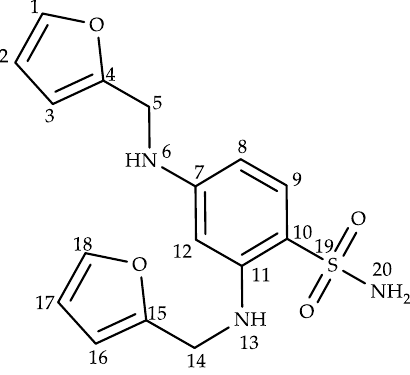
Figure 3. Structure of impurity G. Table 1. 1 H, 13 C-NMR, and 2D-NMR data for impurity G.